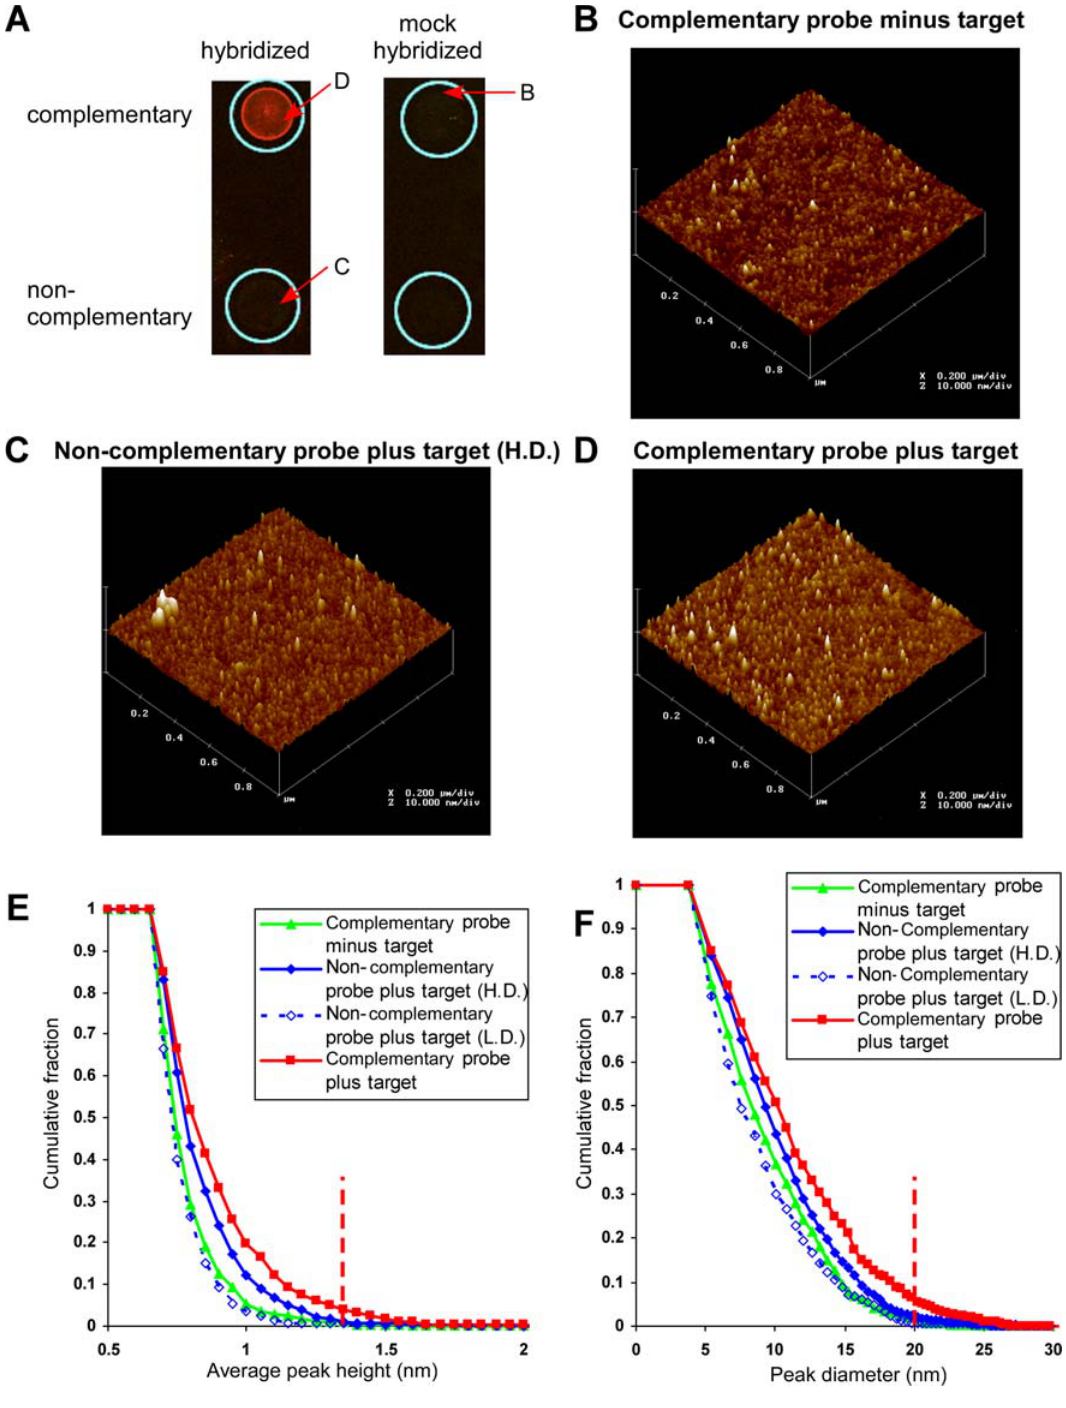
Figure 5. Atomic force microscopy (AFM) of hybridized and mock hybridized spotted 20mer barcodes. A. Fluorescent imaging of hybridized and mock hybridized slides. Each slide contained two spots of oligonucleotides complementary or non-complementary to the labeled target sequence. The location of the AFM scans is indicated by a red arrow. B. Mock hybridized barcode oligonucleotide. 1 m m 6 1 m m scan of the surface arrangement. Pixels are , 2 nm on the x and y axis, and , 100 pm on the z axis. C. High density non-complementary barcode oligonucleotide hybridized in the presence of its non-cognate target sequence. The location of a region of aberrant signal omitted from the analysis is indicated by a red arrow. D. Complementary barcode oligonucleotide hybridized in the presence of its cognate target sequence. E. Cumulative frequency of peak number with increasing height cut-off for high (solid blue) and low density (dashed blue) non-complementary and complementary barcode oligonucleotides minus (green) or plus (red) hybridized target. F. Cumulative frequency of peak number with increasing diameter cut-off for high density (solid blue) and low density (dashed blue) non-complementary and complementary barcode oligonucleotides minus (green) or plus (red) hybridized target. The method of estimation of peak dimensions is described in the Supplementary material (Supplemental text S1). The height and diameter at which 99% of mock hybridized peaks are excluded is indicated by a red dotted line.